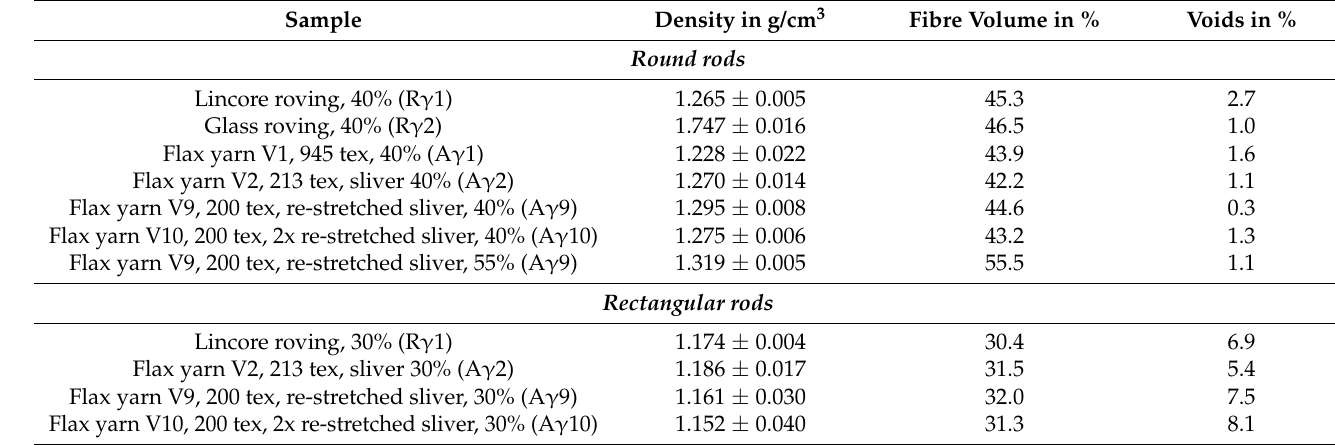
Table 3. Density, calculated fibre volume fraction and void content of pultruded composites (designations in brackets with Greek letters indicate internal labels which are used for the classification of the samples in the